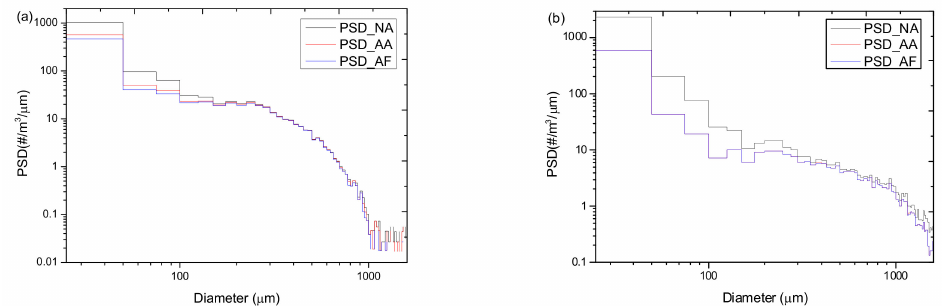
Figure 10. Comparisons of particle concentration distribution measured by a standard CIP before (black, PSD_NA) and after interarrival time corrections with a time-variant threshold (red, PSD_AA) and a fixed threshold (blue, PSD_AF), ( a ) S1, ( b )